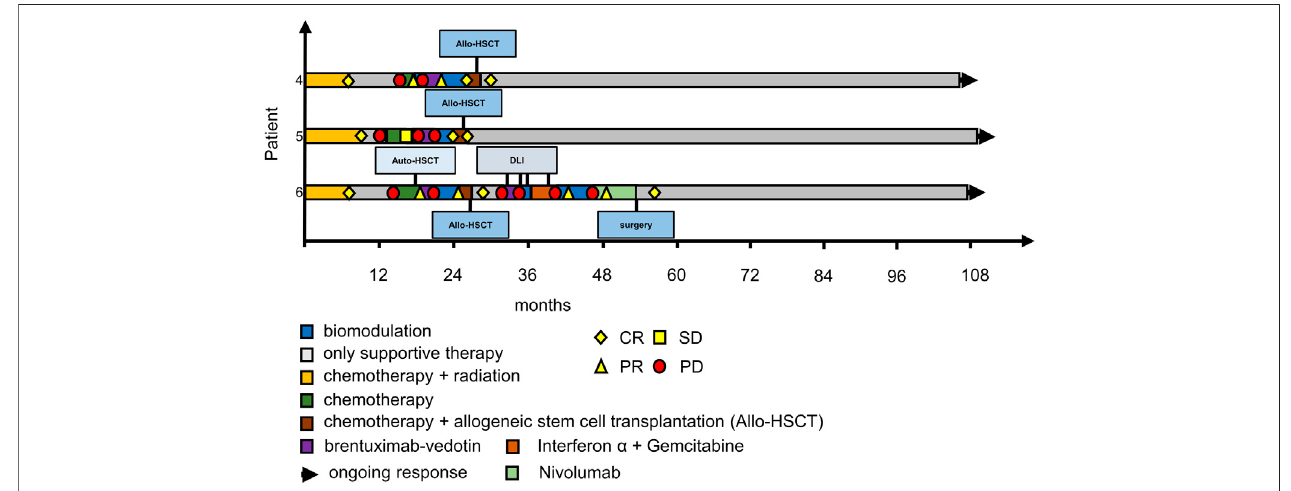
FIGURE 3 | Swimmer plots of patients4 – 6. Patient 4 had achieved CR on asecond course ofMEPED and wasconsolidated by allo-HSCT, he isin remission ever since; patient 5 achieved cCR with MEPED and was consolidated by allo-HSCT, she has been suffering from multiple GVHD complications since, but remains in cCR, patient 6 had relapsed several times after allo-HSCT but achieved cCR after treatment with Nivolumab and resection of residual PET positive cervical lymph nodes. CR: PET negativity(DS-1 to3)plus/minusresidualtumor inCT-scans. PR:PET positivity(DS-4 to5)plus PRaccordingtoRECISTinCTscans.SD:stabledisease.PD: progressive disease. DS: PET Deauville score (1 – 5); DLI: donor lymphocyte infusion; please also see Ugocsai et al. (2016).